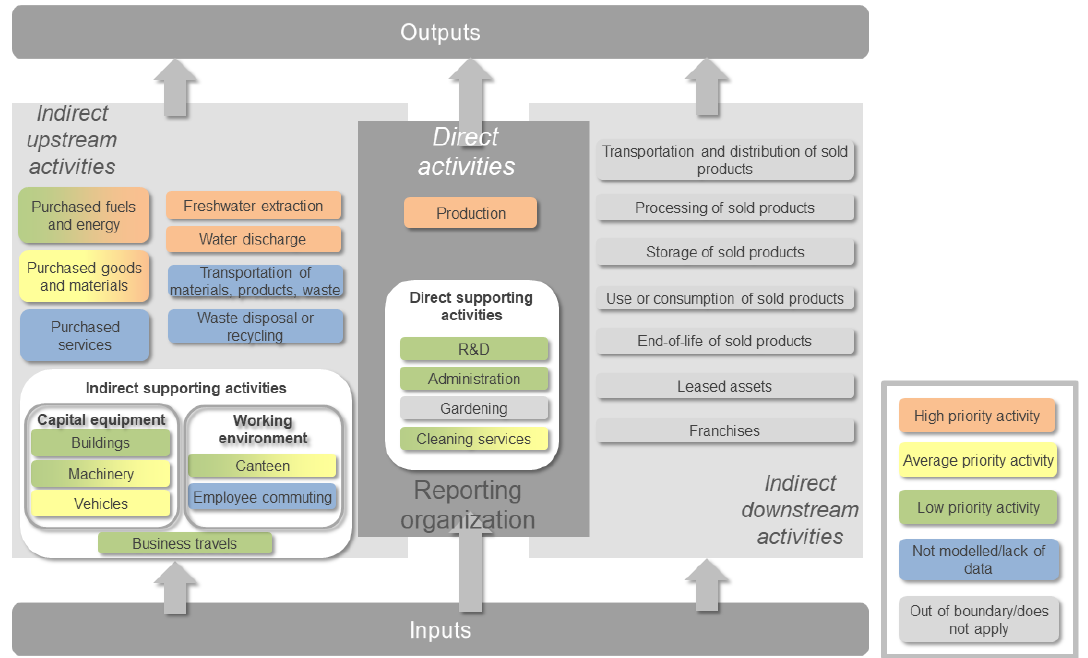
Figure 2. Neoperl’s organization model for the organizational water scarcity footprint case study (own picture adapted from the general model in [7]). The highlighted (non-gray) activities are those carried out in the organization. Gray activities are out of the system boundary, or do not apply for the company. Blue activities take place at Neoperl, but were not modeled due to missing data.